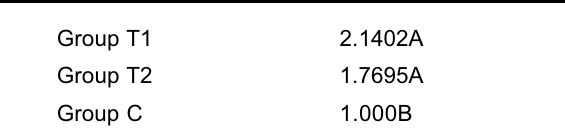
TABLE 1- Means of habitual lip rest posture length (in mm) of groups C, T1 and T2